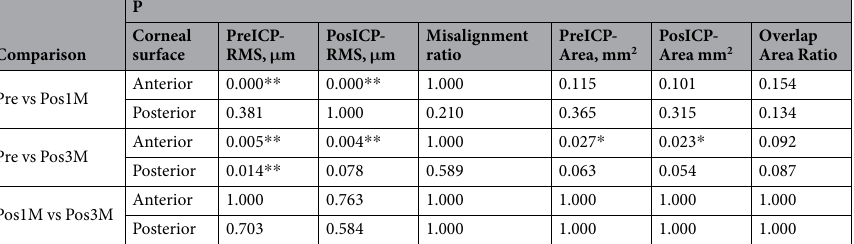
Table 3. Comparison of area and matching error results of the the first and second measurement. Pre means the period pre operation, Pos1M means 1 month post LASIK, Pos3M means 3 months post LASIK; PreICP-RMS and PosICP-RMS represent the root-mean-square error of the coordinate differences of corneal surface between two successive measurement before and after topography matching, respectively, Misalignment ratio = 1 - PosICP-RMS/PreICP-RMS; PreICP-Area, PosICP-Area represent the Overlap area of corneal surface between two successive measurements before and after topography matching, respectively; Overlap Area ratio = Pri- Area/Cor-Area; * means P < 0.05, ** means P < 0.01.